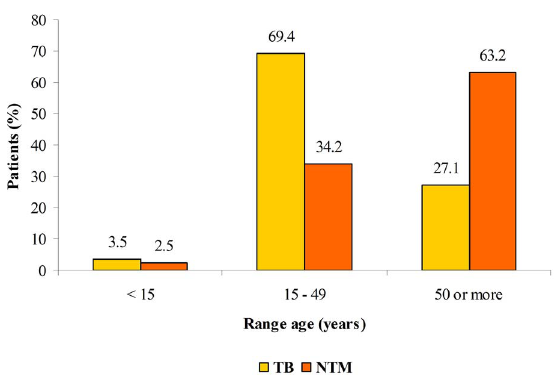
Figure 1. Proportion of tuberculosis and nontuberculous mycobacterial lung disease by age group - State of Para, Brazil, 2010–2011.